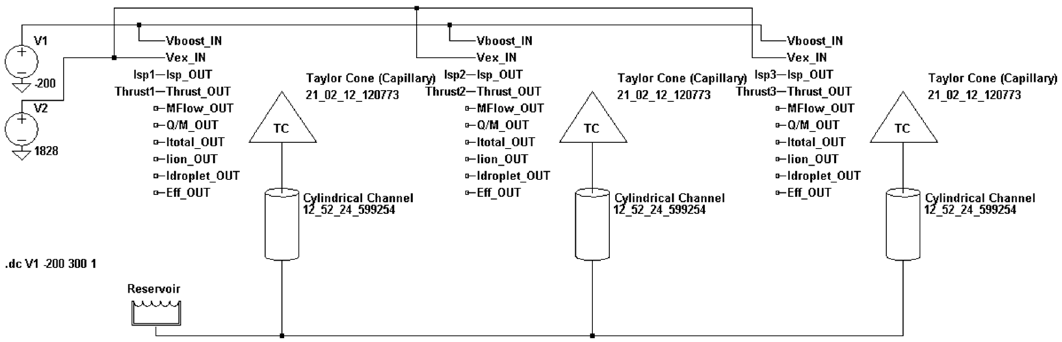
Figure 10. SPICE schematic of three emitter array in microfluidic network.